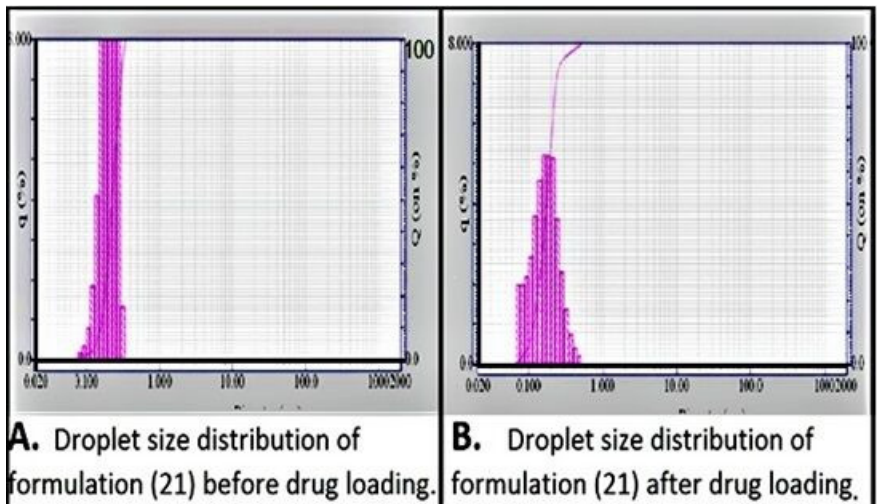
Figure 4. Graphs showing droplet size distribution of selected formulation where ( A ) Droplet size distribution of formulation 21 before drug loading and ( B ) Droplet size distribution of formulation 21 after drug loading.